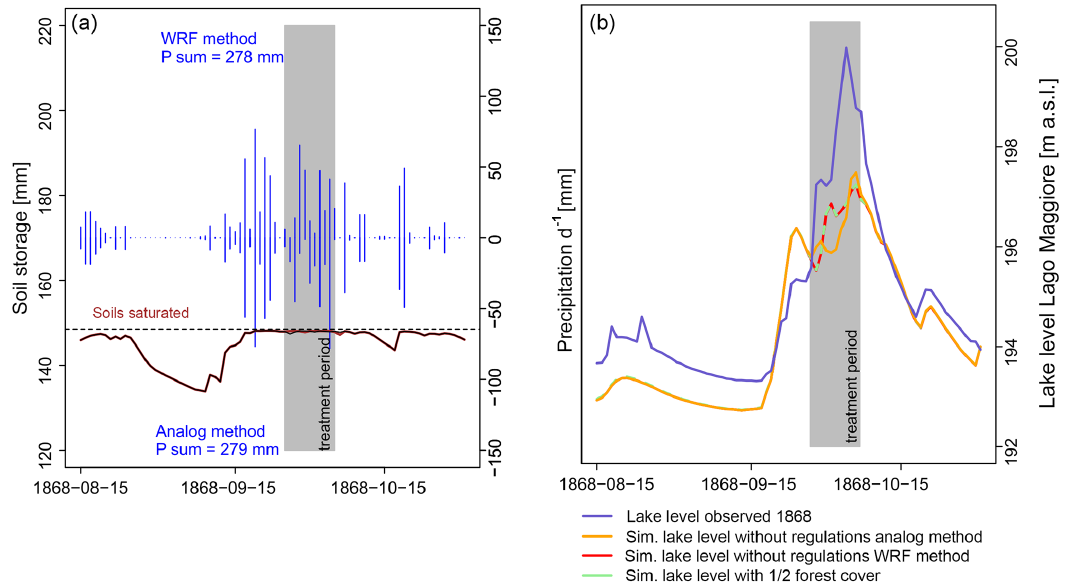
Figure 12. Hydrological simulation of the 1868 flood event in the LMR. Panel (a) displays the precipitation input to the system (area averages in mm) for the WRF downscaling simulation (positive values) and the analog resampling method (negative values), as well as mean areal soil storage. Panel (b) shows the observed (blue lines) and simulated (colored lines) lake levels from August to October 1868. WRF scenarios are only simulated for the treatment period shaded in grey. The deforestation scenario was computed for a full hydrological